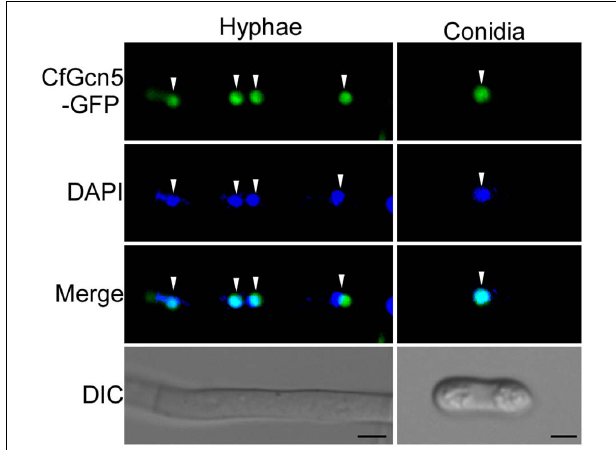
FIGURE 8 | CfGcn5 is localized to the nucleus. The nuclei were stained with 4, 6-diamidino-2-phenylindole (DAPI). CfGcn5-GFP co-localized with DAPI in hyphae and conidia. Arrowheads show the representative co-localized areas. Bar = 5 µ m.